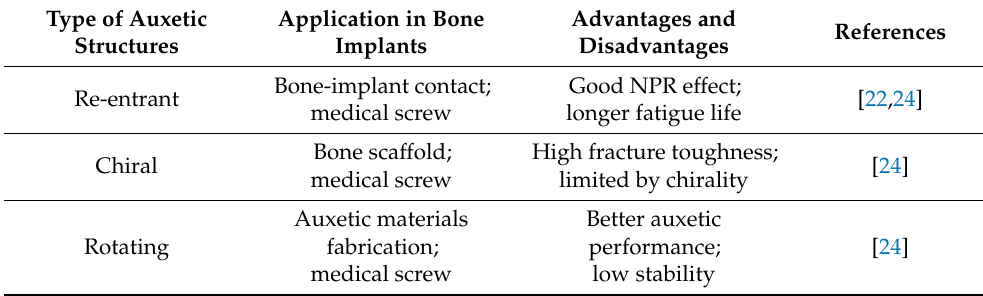
Table 3. The auxetic structures and their applications in bone